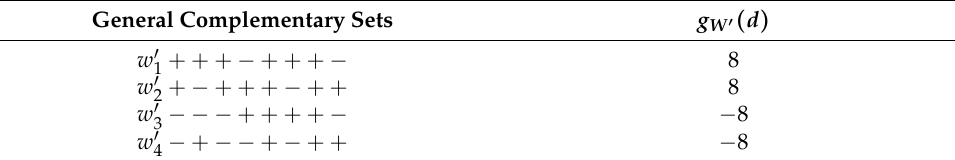
Table A4. Example for the illustration of Property 2 ( L =